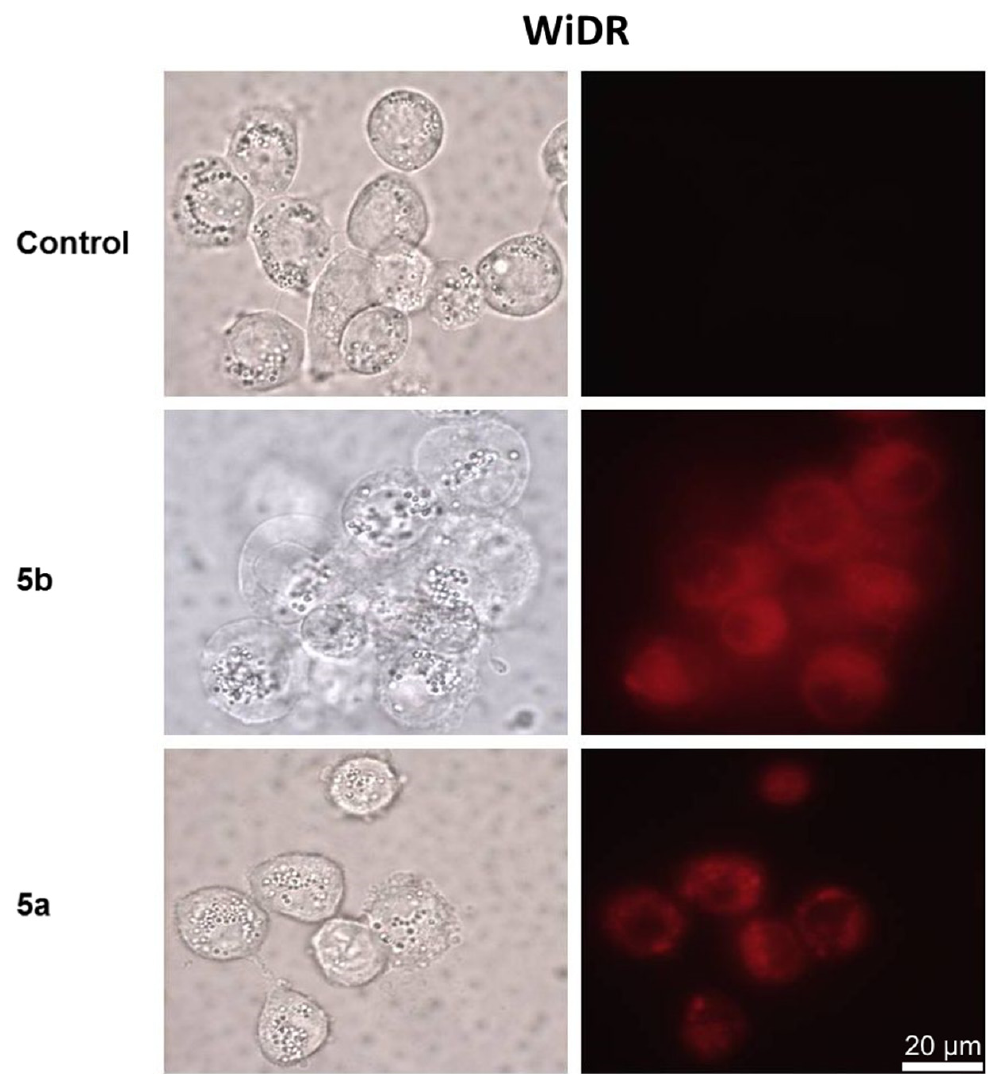
Figure 4. Cellular localization of PpIX derivatives, 5a and 5b , in WiDR cells. Scale bar = 20 μ m.